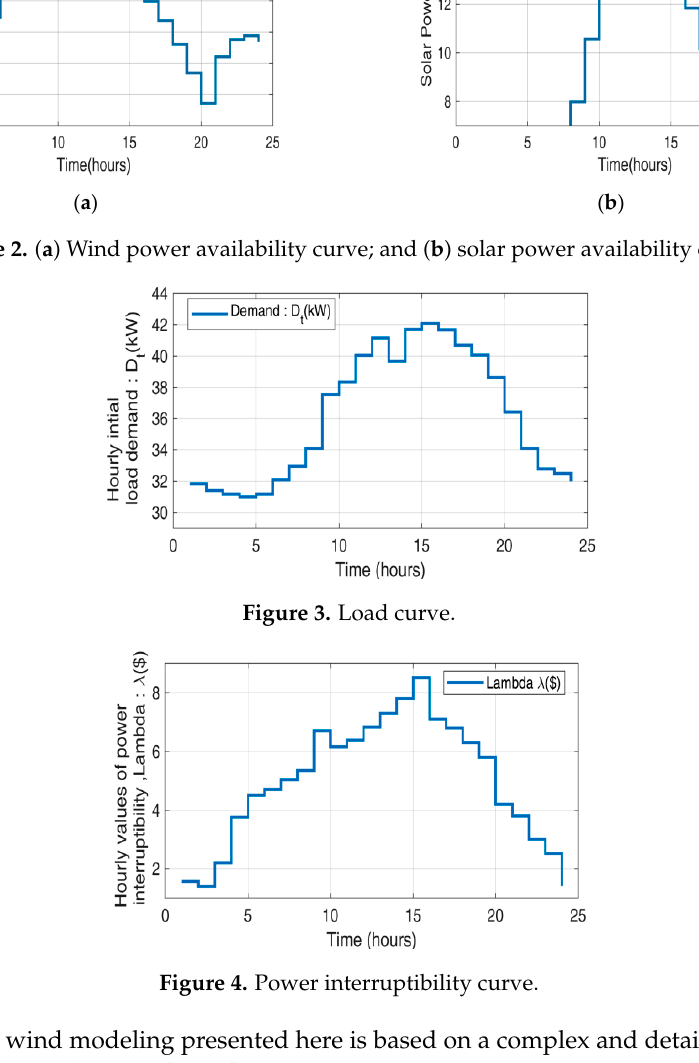
Figure 5. Formulation of multi-objective function F ( X ). 3.1. Objective1: Minimization of the Fuel Cost Function, G(X) In this mode the reduction of the fuel cost of microgrid generators is the main objective. In this work, a power exchange scheme is assumed to exist between the main grid and microgrid. This